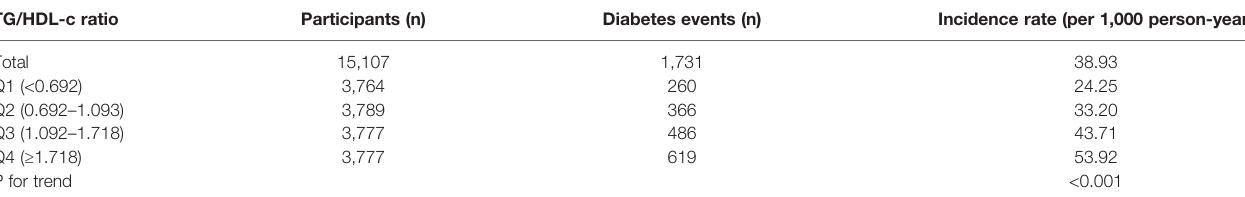
TABLE 2 | The incidence rate of diabetes in participants with prediabetes (per 1,000